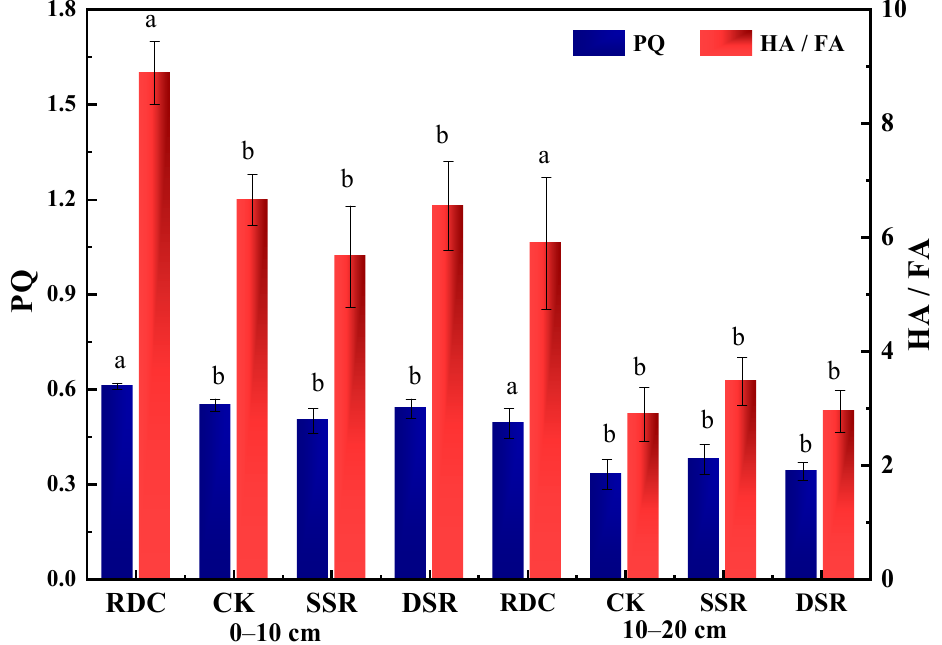
Figure 5. Improvements of different patterns on the structural characteristics of soil humus. HA, humic acid; FA, fulvic acid; HE, extractable humus; PQ, HA/HE. Small letters show the significant difference.